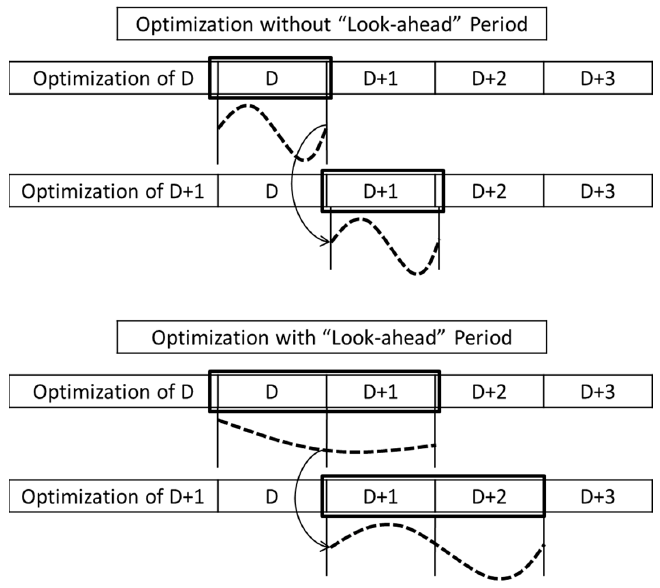
Figure 1. Scheme of the proposed methodology to determine the reservoir initial volume.